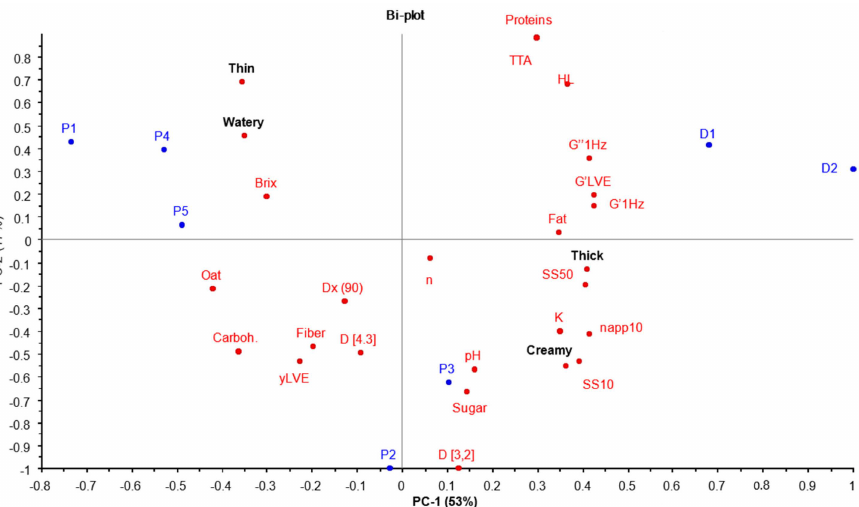
Figure 4. PCA biplot (scores and loadings) of the physicochemical properties for plant-based and dairy yogurts plus the following mouthfeel sensations: thick, creamy, thin, and watery. The abbrevia- tions of the physicochemical parameters are in accordance with Table